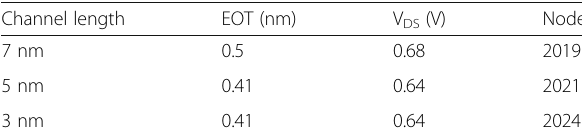
Table 1 Device parameters following ITRS and IRDS requirement Channel length